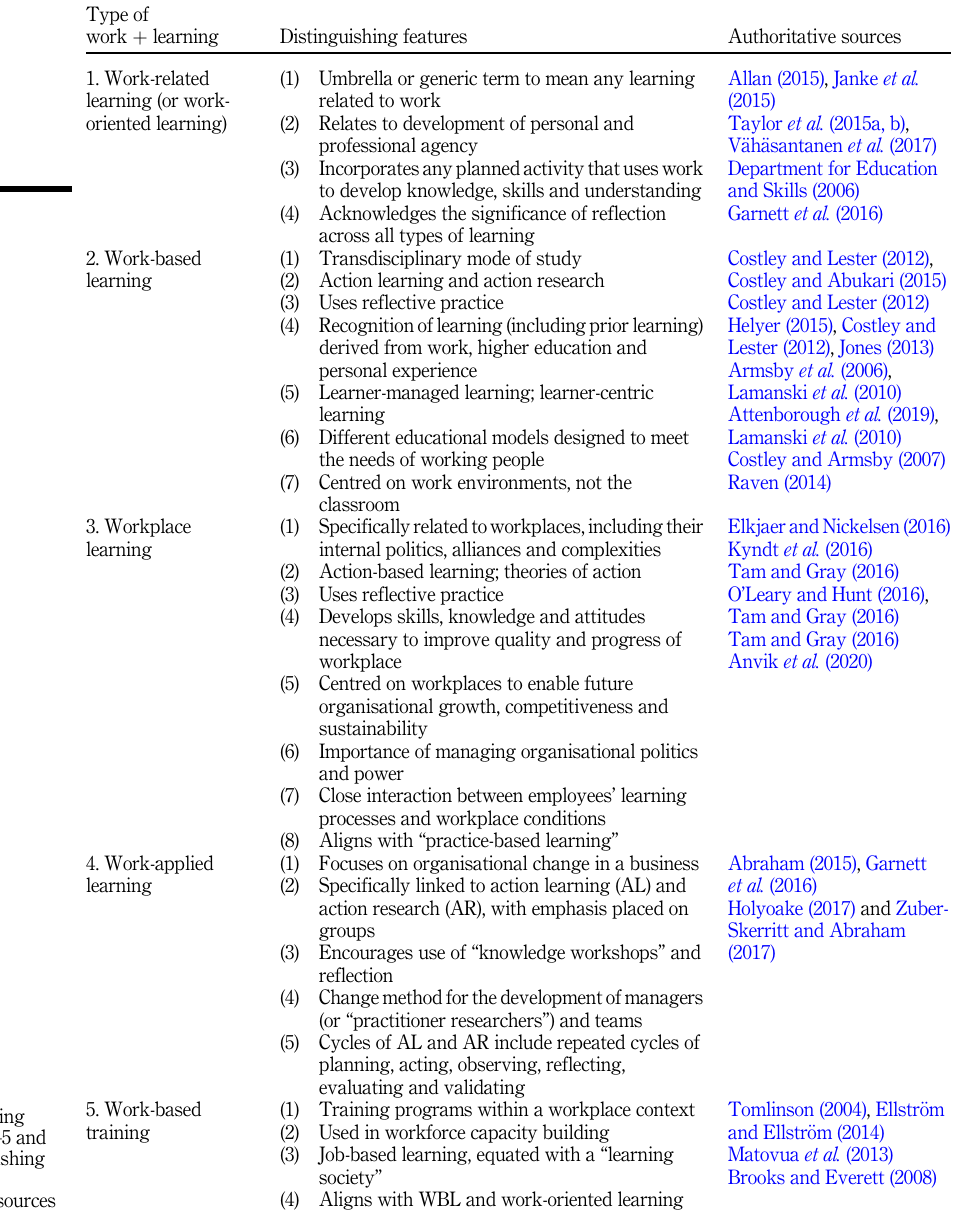
Table 1. Work þ learning pedagogies 1 – 5 and their distinguishing features and authoritative